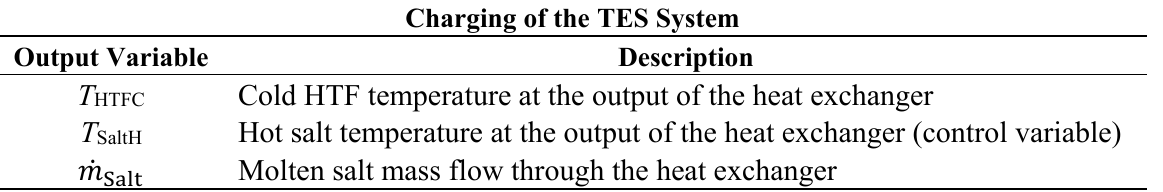
Table 5. TES charging output variables.